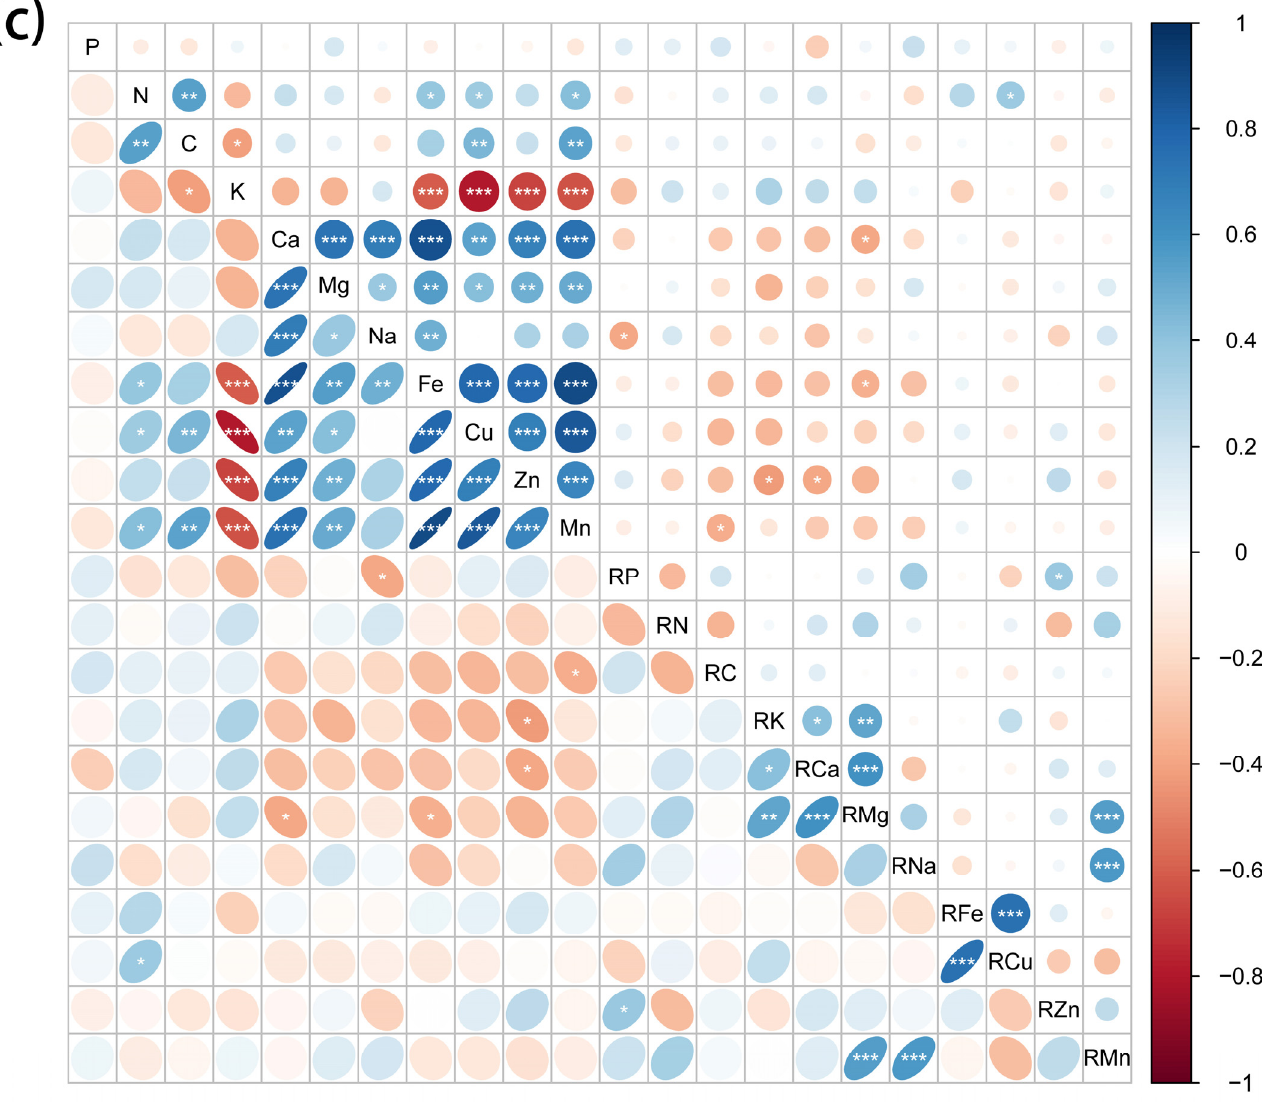
Figure 3. Pearson correlations between leaf ( a ), stem ( b ) and root ( c ) minerals and soil nutrients. Leaf, stem and root minerals (mg g − 1 ) were log 10 transformed before analysis. Soil elements are content based (mg g − 1 ). “*”, “**” and “***” indicate that the difference is significant ( p < 0.05), highly significant ( p < 0.01) and very significant ( p < 0.001).